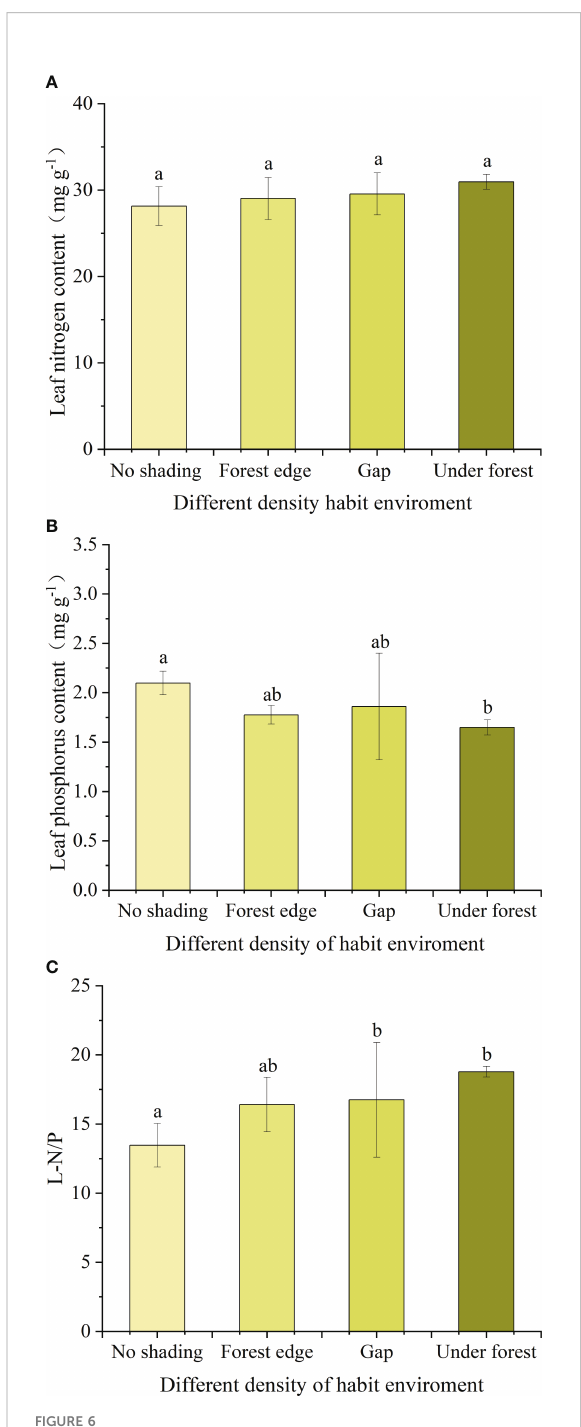
FIGURE 6 EffectsofdifferentlightconditionsoncharacteristicsofleafNandPof Acer catalpifolium . (A) leafNcontent, (B) leafPcontentand (C)